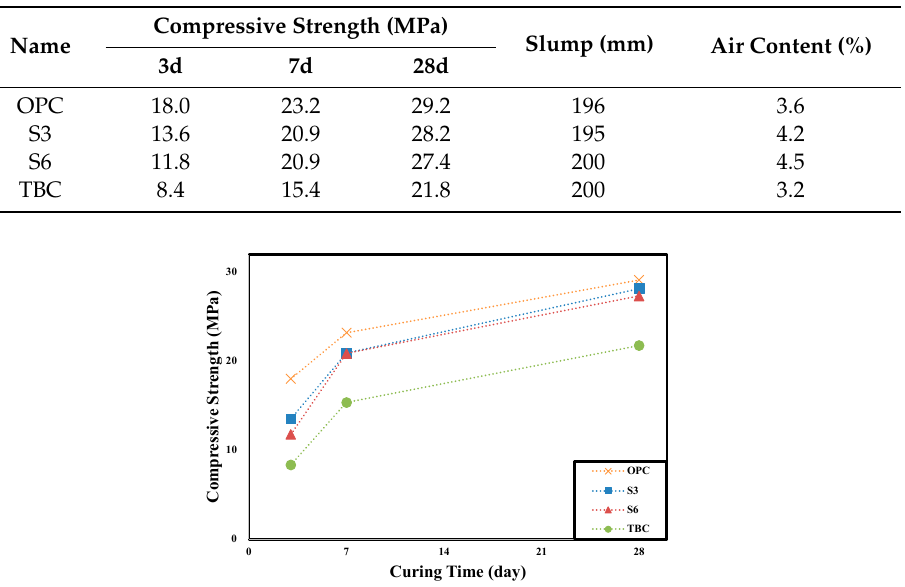
Table 5. Result of concrete compressive strength tests.